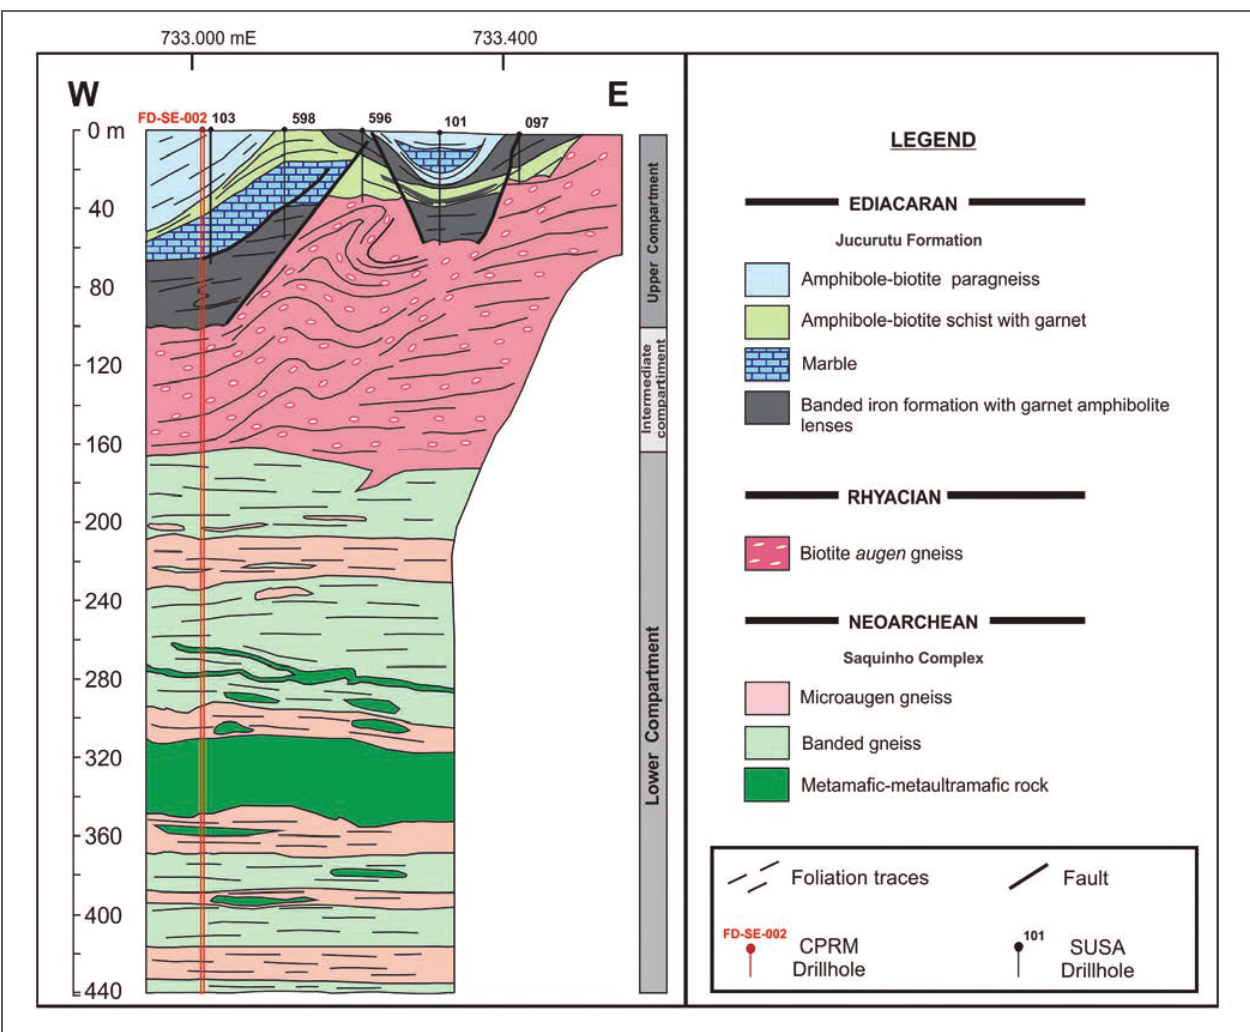
Figure 18 - Geological section of northern Saquinho iron mine, composed of the FD-SE-002 borehole and others made by Susa Indústria e Comércio de Produtos Minerários